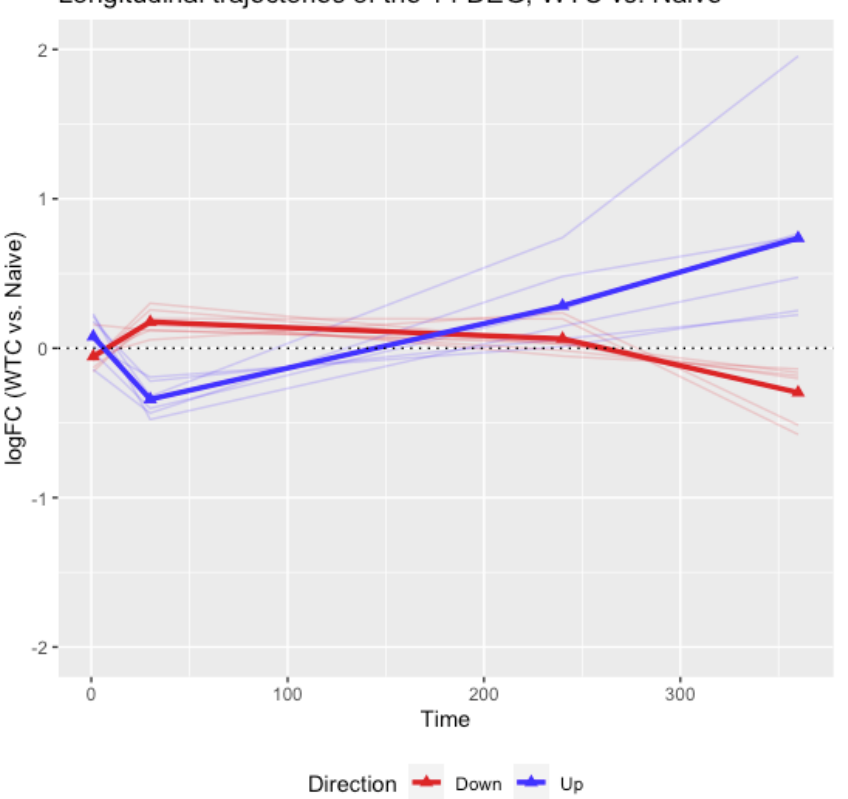
Figure 2. The longitudinal trajectories of logFC between WTC and Naive for the 14 DEGs. The 14 DEGs were identified at day 360 as listed in Table 1. The blue lines referred to DEGs up-regulated at day 360, also labeled as ‘Up’, and the red lines referred to DEGs down-regulated at day 360, labeled as ‘Down’. The bold lines connecting the triangles are the mean